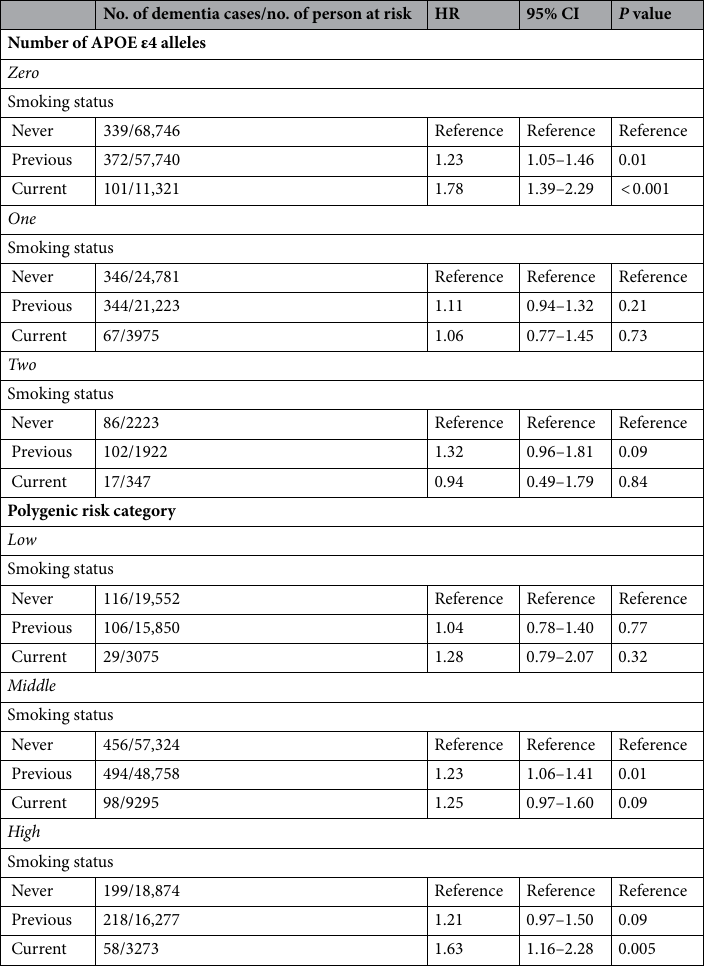
Table 3. Risk of incident dementia according to smoking status within each APOE genotype and polygenic risk category. All analyses were adjusted for age, sex, educational attainment, deprivation quantile, BMI, parental dementia status, and 5 principal components of ancestry. HR hazard ratio, CI confidence